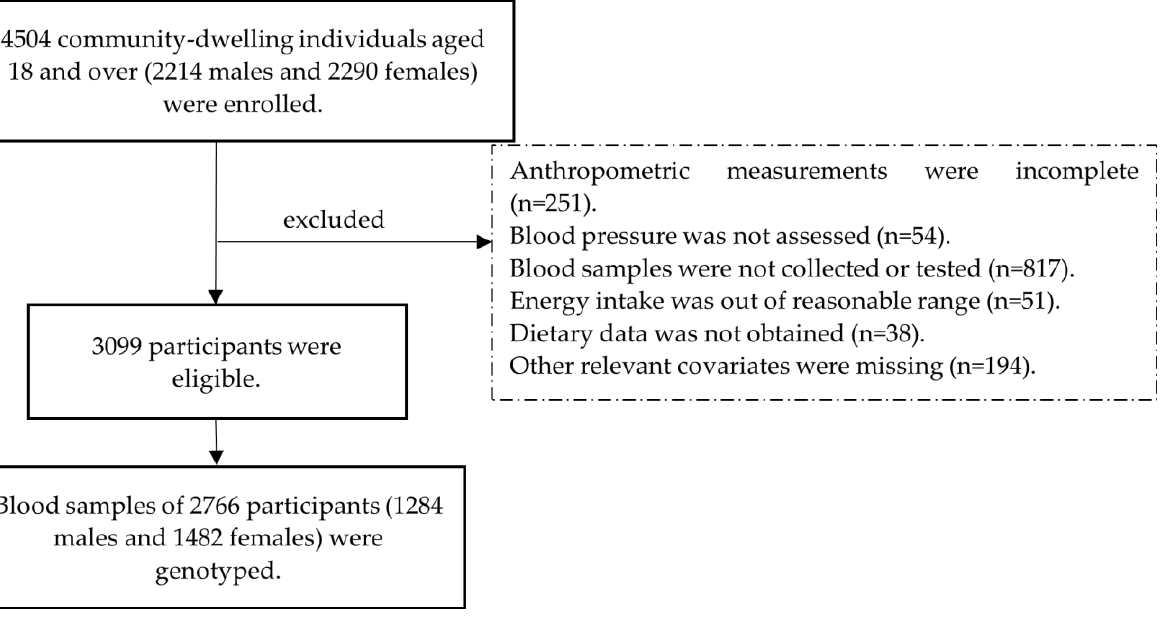
Figure 1. Flow chart of the study participants.